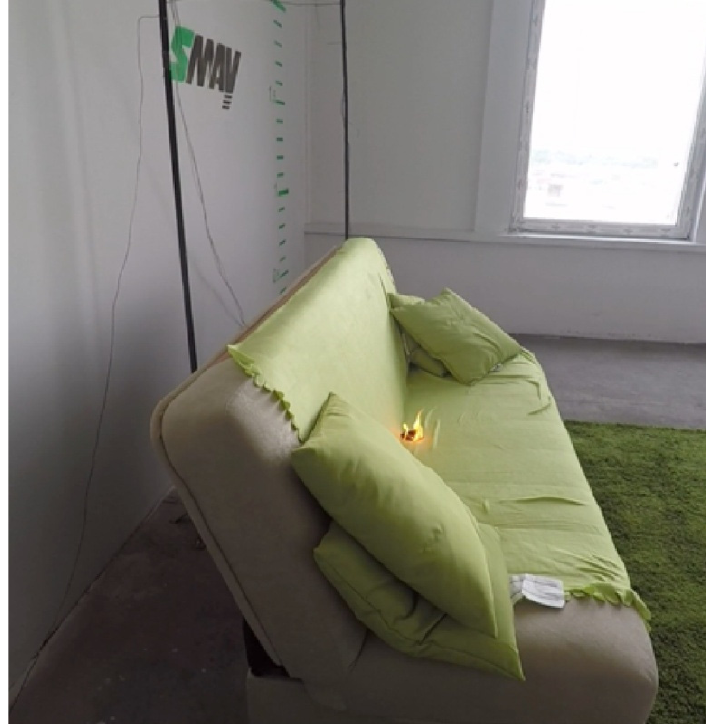
Figure 3. The location of the ignition source on the sofa at the beginning of a fire.